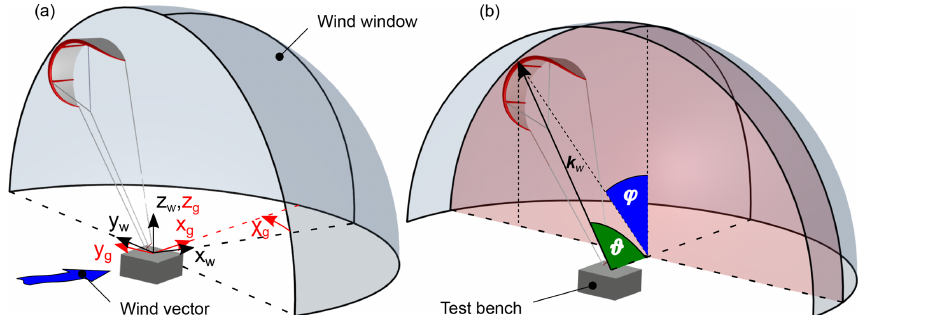
Figure 9. Cartesian coordinates for X g < 0 ◦ , index “g”: reference to the test bench, index “w”: reference to the wind direction (a) , elevation angle ϑ and azimuth angle ϕ for X g = 0 ◦ (b)